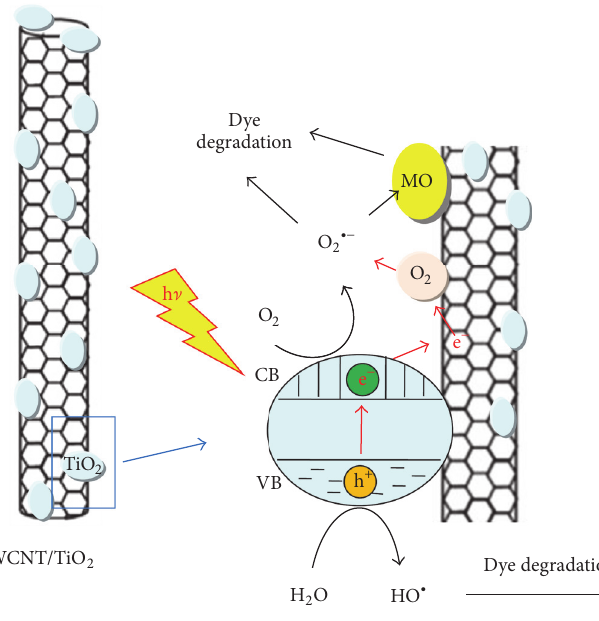
Figure 9: Schematic diagram of the proposed mechanism of photocatalytic degradation in MWCNTs/TiO 2 under UV